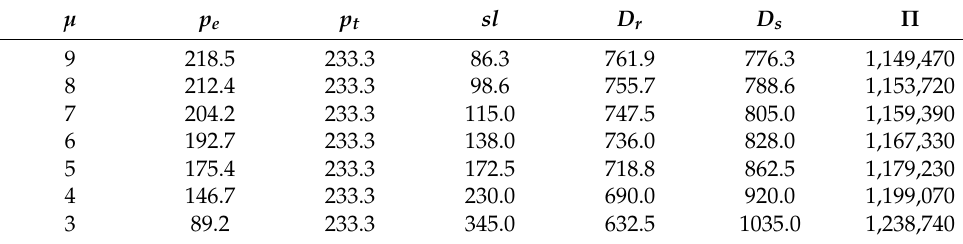
Table 3. The effect of µ on decision and profit under the centralized mode.